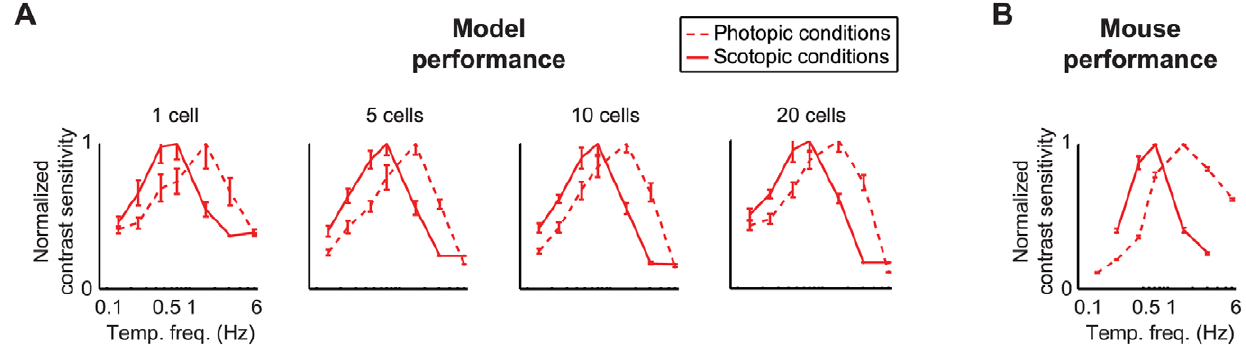
Figure 6. The model predicted the shift in optomotor performance. Each plot shows normalized contrast sensitivity under photopic and scotopic light conditions. ( A ) The model predicts a shift toward higher temporal frequencies as the animal moves from scotopic to photopic conditions, with the peak shifting from 0.7 Hz to 1.5 Hz. The prediction was robust from 1 cell to saturation (20 cells). ( B ) The animals’ behavioral performance shifted to higher temporal frequencies, as predicted ( n =5 animals). Error bars are